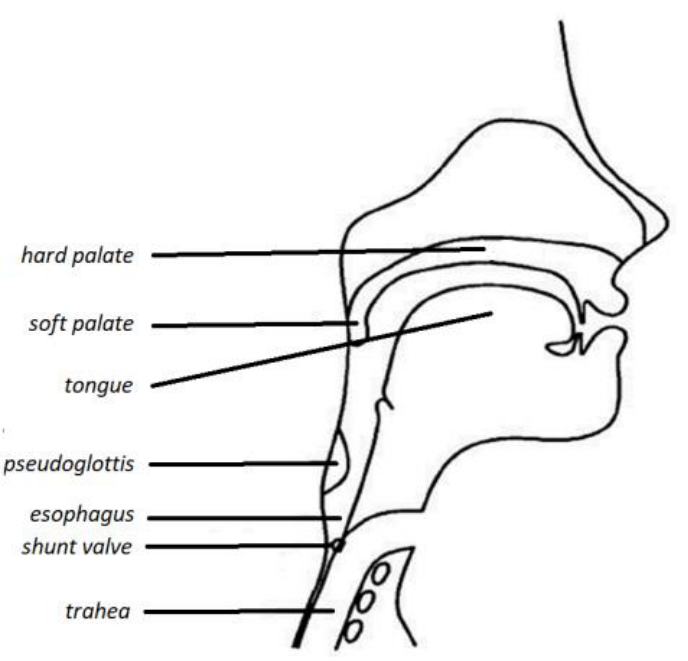
Figure 1. View following total laryngectomy. The pseudo-glottis is visible (own version). The paper is divided into the following